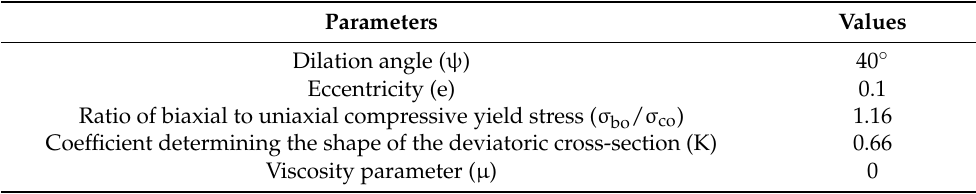
Table 2. Plasticity flow parameters for CDP model